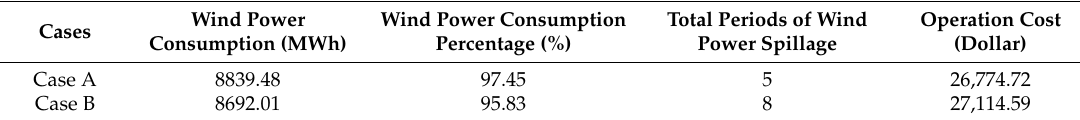
Table 3. Numerical results for cases considered.